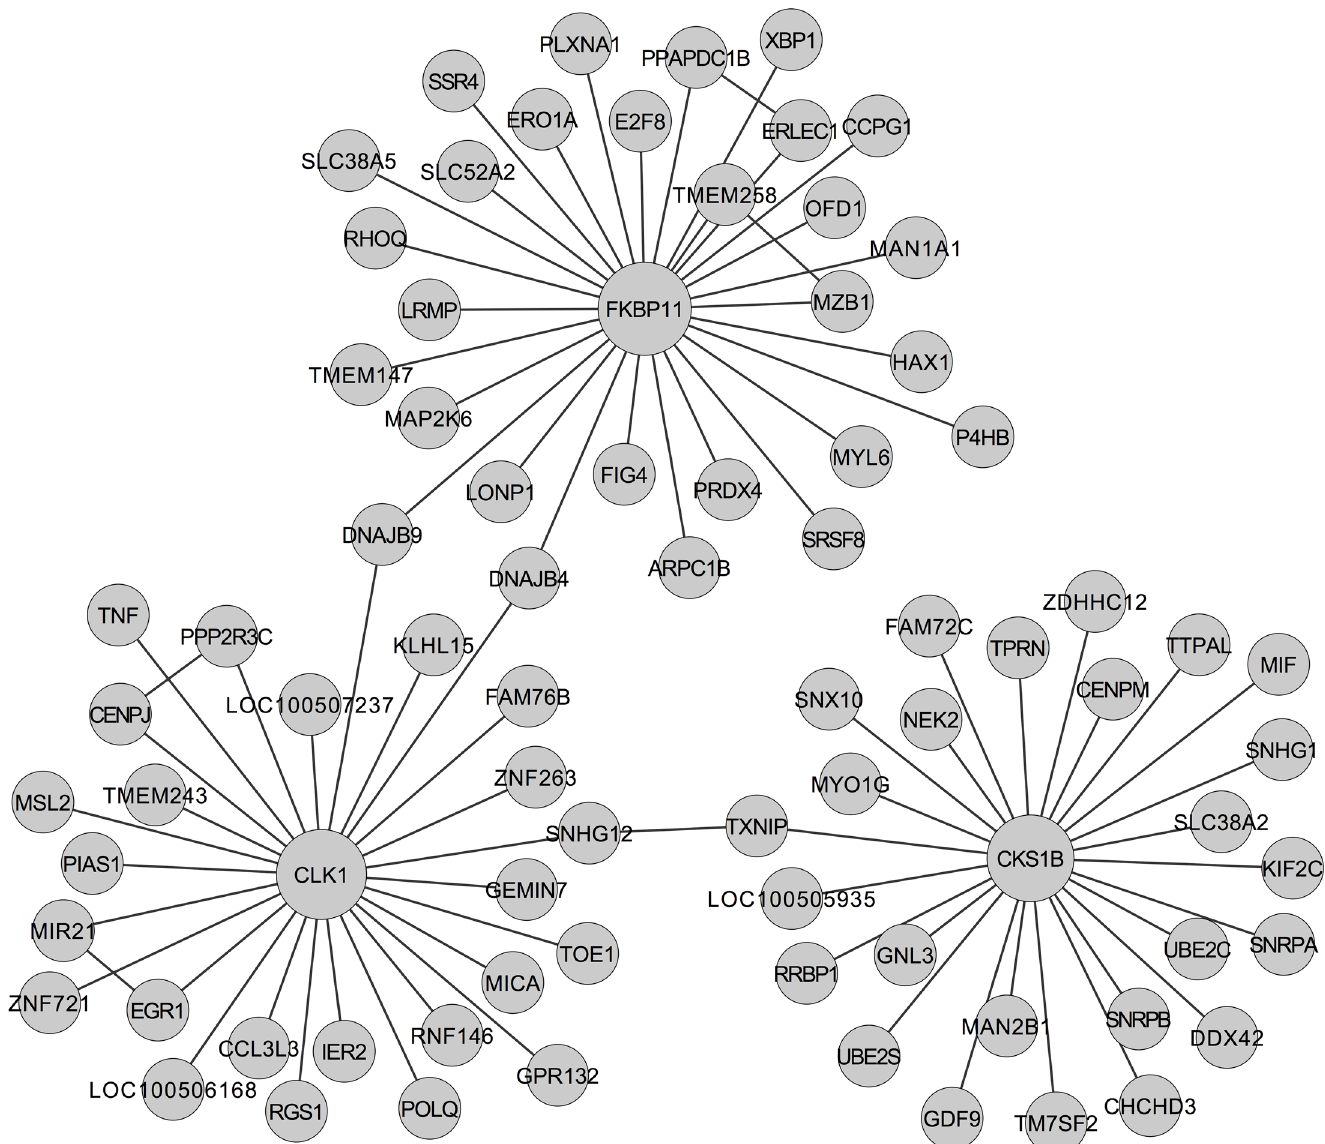
Fig 3. Sub-network of differential gene-gene associations between asthmatic and healthy conditions. The sizes of nodes are proportional to their degrees.